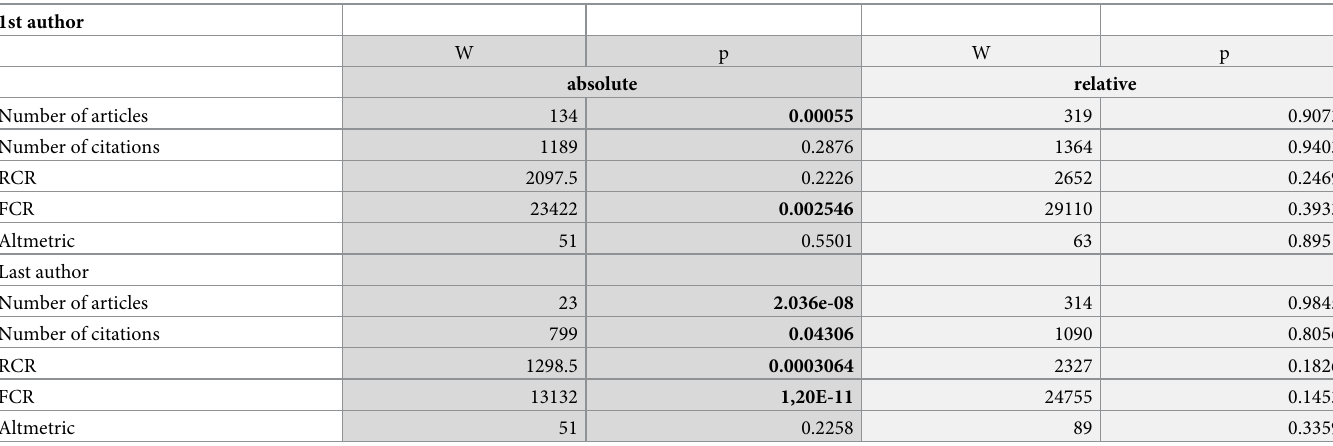
Table 3. Traditional and alternative metrics of research papers considering absolute vs relative values between sexes in Brazilian Entomological